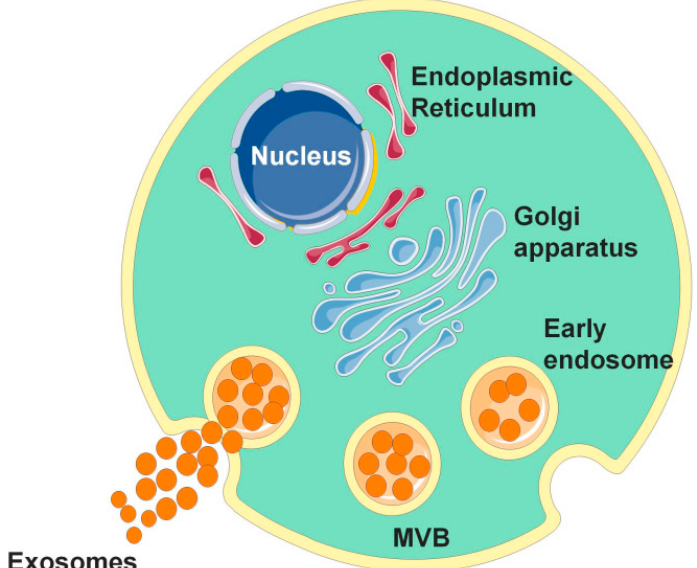
Figure 1. The occurrence of exosomes. The occurrence of exosomes is formed by the invagination of the cell membrane to form multivesicular bodies (MVBs). After the outer membrane of MVB fuses with the cell membrane, its contents are released into the extracellular matrix, and the secreted vesicles are called exosomes.